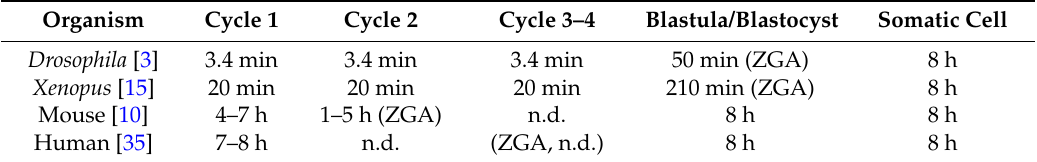
Table 1. S-phase length during early animal embryonic development and compared to somatic cells. The length of S-phase in different organisms is indicated. Measurements in mammalian embryos are less precise due to the difficulty to obtain embryos and to the different experimental conditions employed. ZGA indicates activation of zygotic transcription. n.d.: not